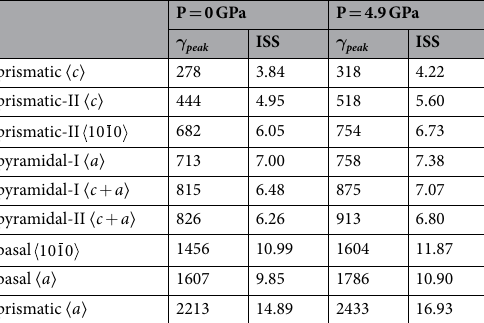
P = 0 GPa P = 4.9 GPa